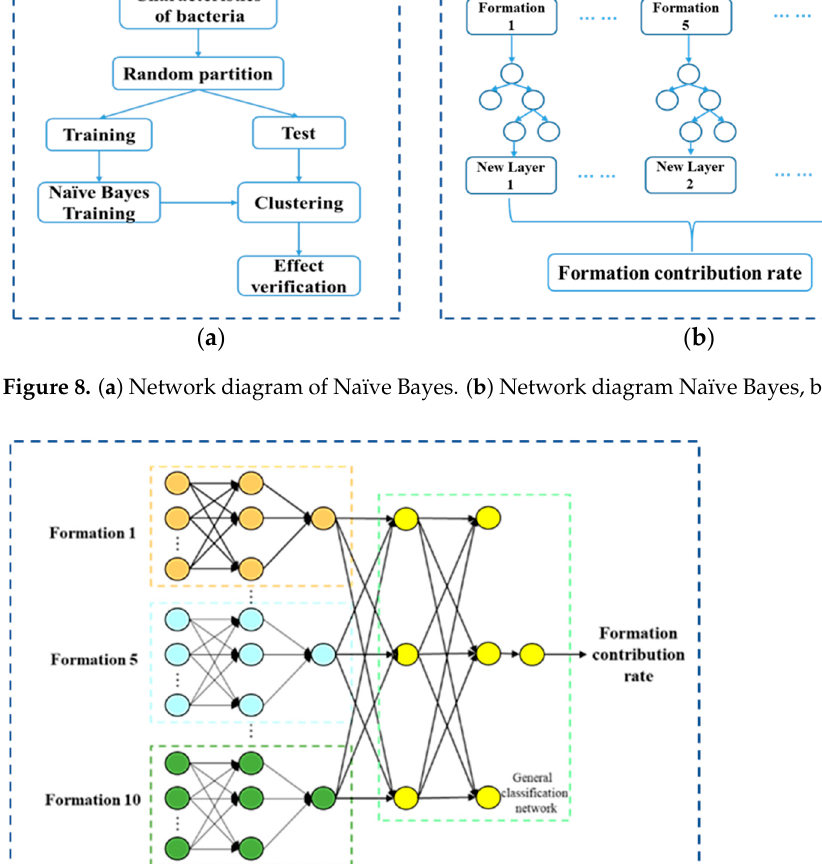
Figure 8. ( a ) Network diagram of Naïve Bayes. ( b ) Network diagram Naïve Bayes, back propaga- tion.